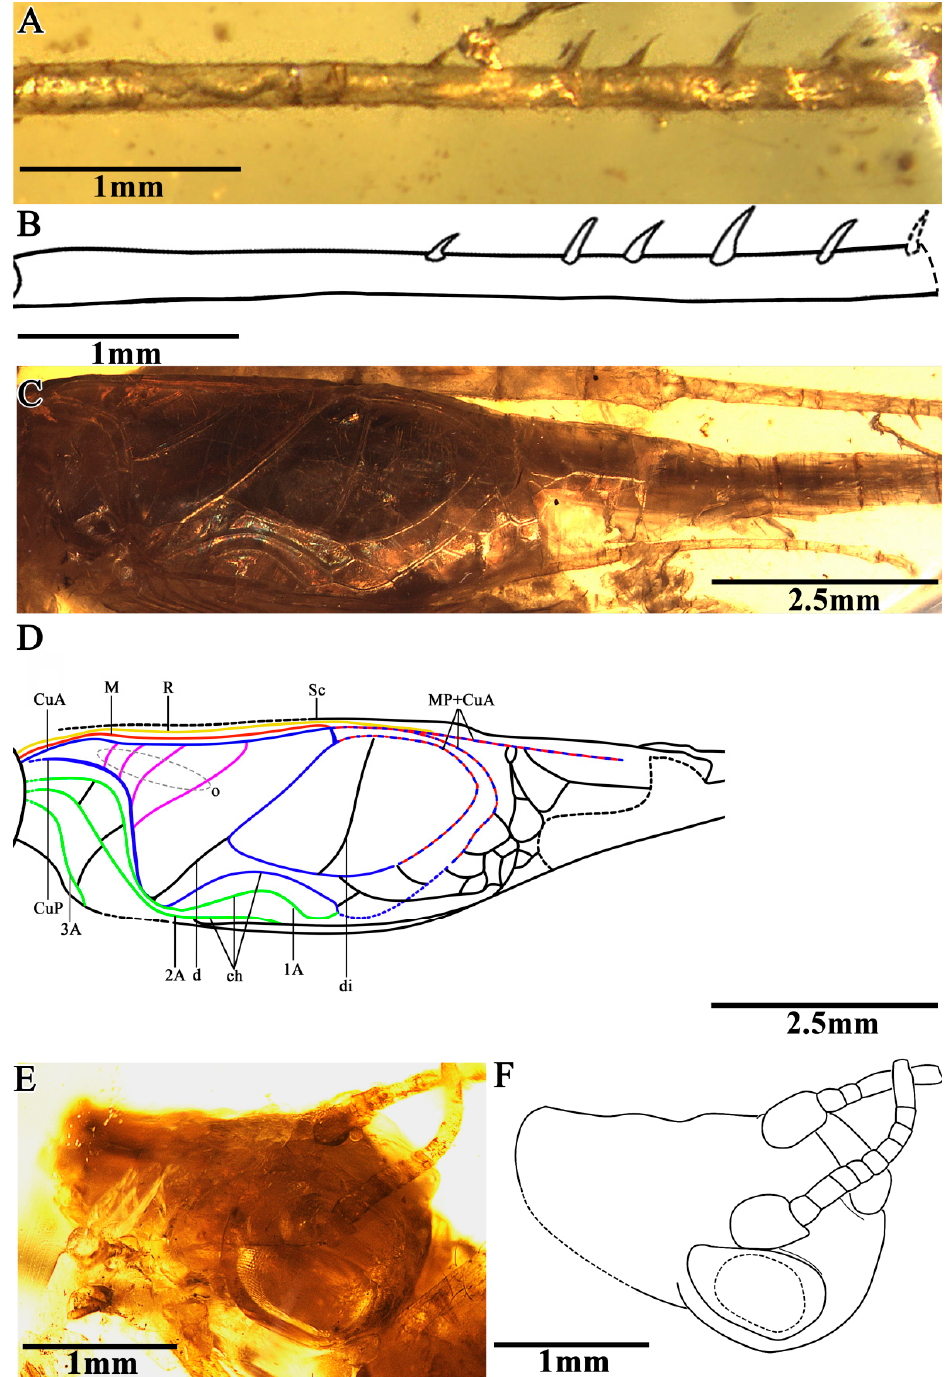
Figure 2. Details of B. haplostichus sp. nov.: ( A ) photograph of left metatibia, ( B ) line drawing of left metatibia, ( C ) photograph of left tegmina, ( D ) line drawing of left tegmina, ( E ) photograph of head, and ( F ) line drawing of head. (Description of the color lines in ( D ): the yellow line represents radius vein (R); the red line represents media vein (M); the blue lines represent cubitus veins (CuA, CuP); and the green lines represent anals veins (1A, 2A and 3A); the pink lines represent oblique vein (o)). The pronotum transversal, anterior, and posterior margin were aequilate and slightly wider than the head; the disc had a longitudinal groove in the middle and two pairs of marks in different sizes; and the lateral lobes had a prominent dark